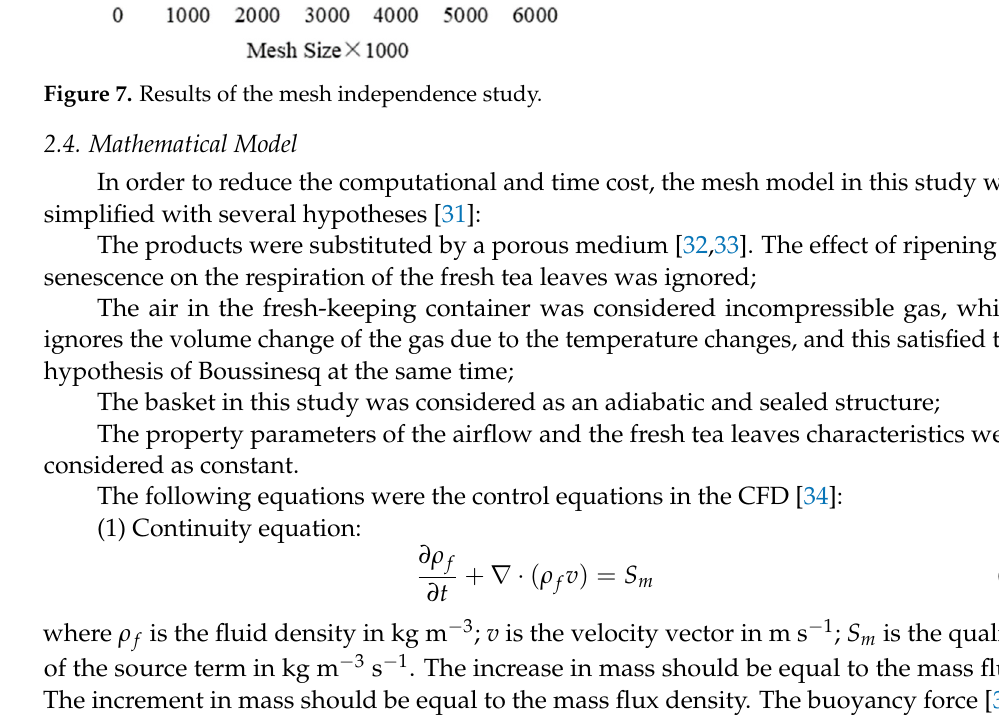
7 of 21 Figure 6. Mesh model. The calculation results and calculation time are affected by the mesh size and number [27,30]. A coarse mesh can reduce the computational cost, while a small mesh size can help enhance the computational efficiency. Therefore, the proper mesh size for a model should be investigated, and a mesh independence test was performed with temperature variations on fresh tea leaves under the same ambient air temperature to study the mesh models with different mesh numbers ranging from 1.3 * 106 cells initially to approximately 5.3 * 106 cells. Meanwhile, the mesh density improved in some areas, such as the outlet, the velocity inlet, and the product, to enhance the computational accuracy in the simulation of these components.